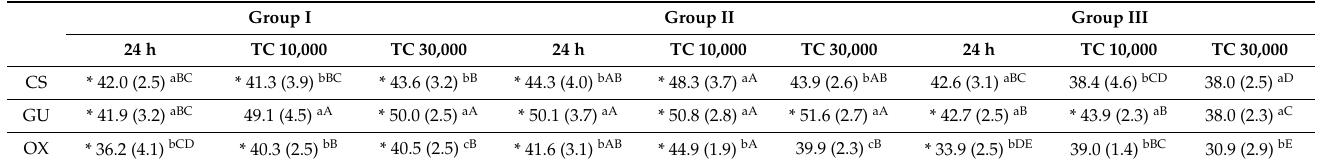
Table 4. Influence of application method on enamel bond strength (ER mode). Group I